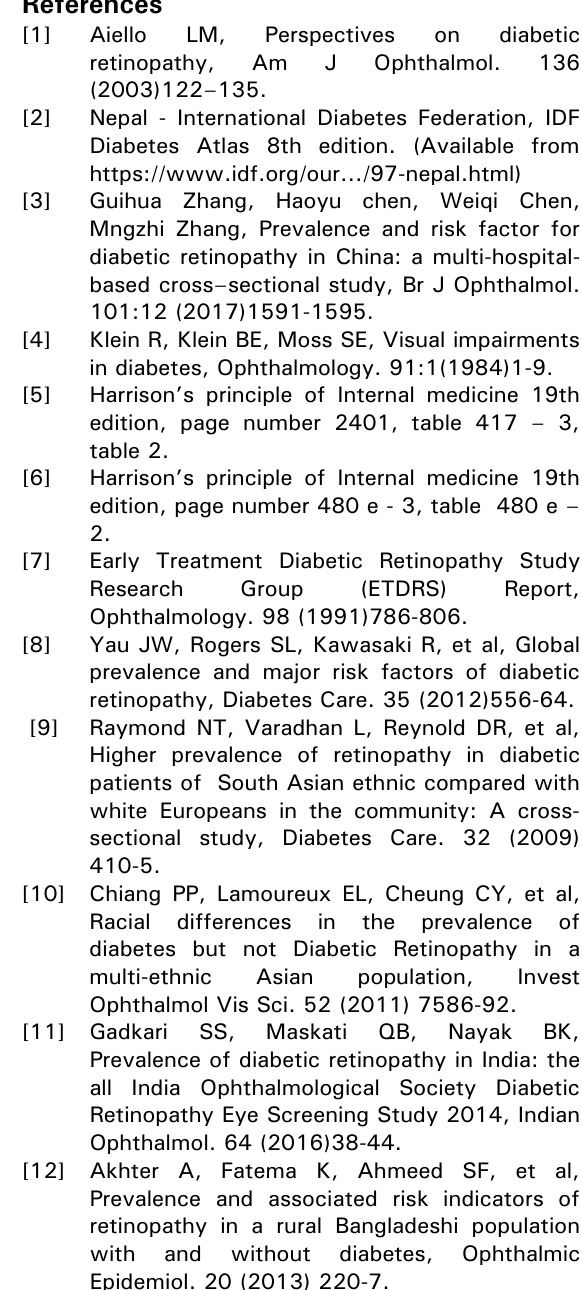
Racial differences in the prevalence of diabetes but not Diabetic Retinopathy in a multi-ethnic Asian population, Invest Ophthalmol Vis Sci. 52 (2011) 7586-92. Nayak BK, Prevalence of diabetic retinopathy in India: the all India Ophthalmological Society Diabetic Retinopathy Eye Screening Study 2014, Indian Ophthalmol. 64 (2016)38-44. [12] Akhter A, Fatema K, Ahmeed SF, et al, Prevalence and associated risk indicators of retinopathy in a rural Bangladeshi population with and without diabetes, Ophthalmic Epidemiol. 20 (2013)